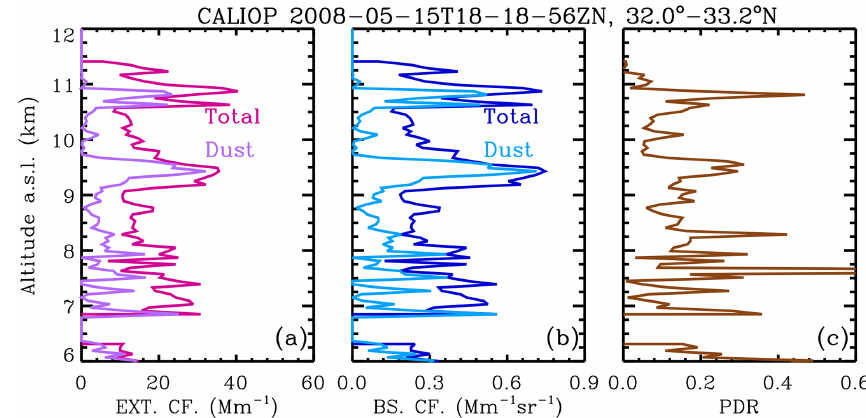
Figure 5. Profiles of the 532nm (a) dust and total (dust + non-dust) extinction coefficient, (b) dust and total (dust + non-dust) backscatter coefficient, and (c) particle depolarization ratio obtained/calculated from the CALIOP Level-2 aerosol profile product on 15 May 2008. The profiles within the latitude range of 32.0–33.2 ◦ N are integrated